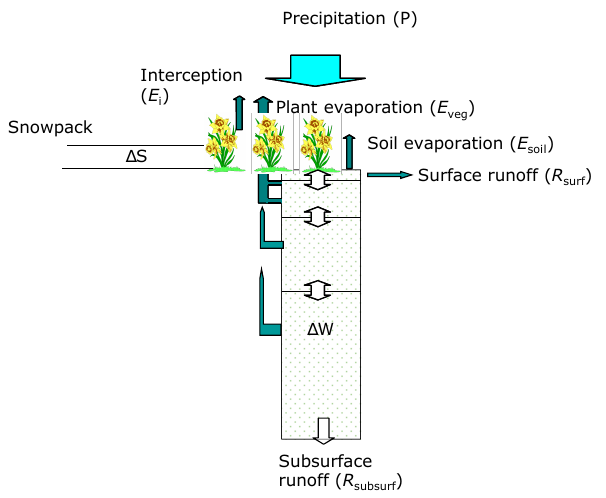
Fig. 1. Water balance of the land surface scheme HTESSEL.